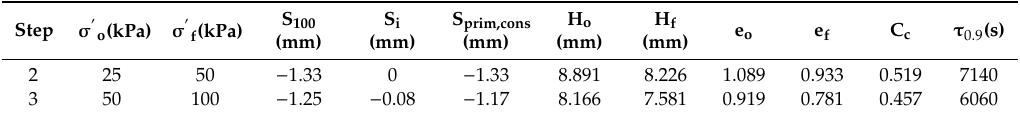
Table 3. Data obtained from compressibility and consolidation curves in clayey soil with muscovite (steps 2 and